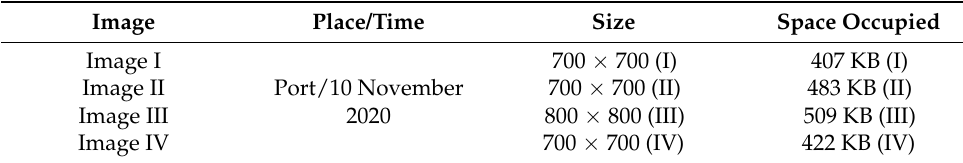
Table 2. Captured experimental image information.